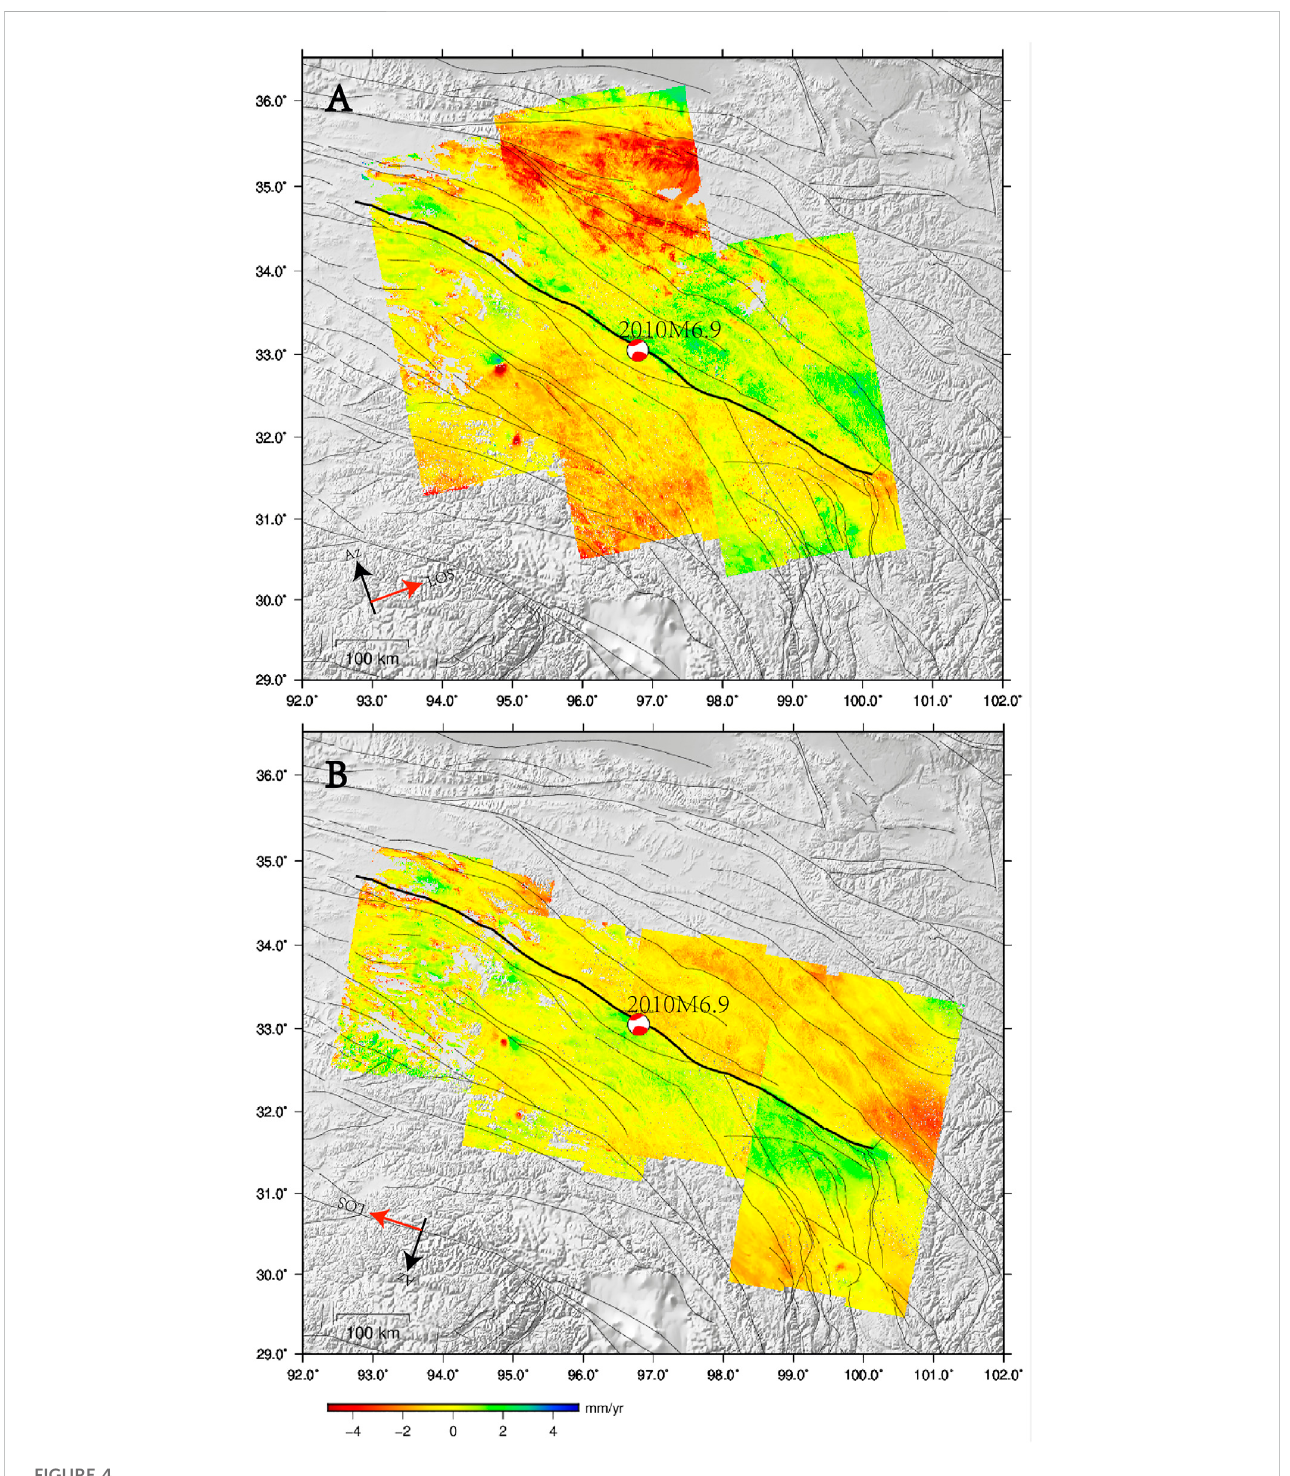
FIGURE 4 InSARLOSvelocity fi eldsfor (A) ascendingtracksA70,A172,andA99and (B) descendingtracksD77,D4,D106,andD33.TheblacklineistheGanzi-Yushu